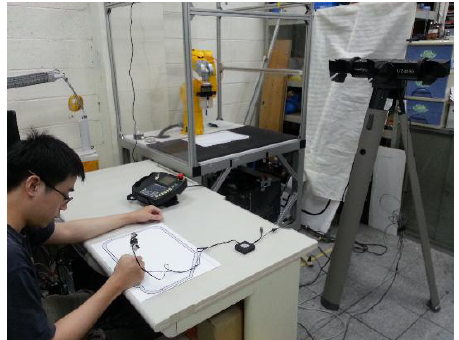
Figure 4. Environment setting of the proposed teaching